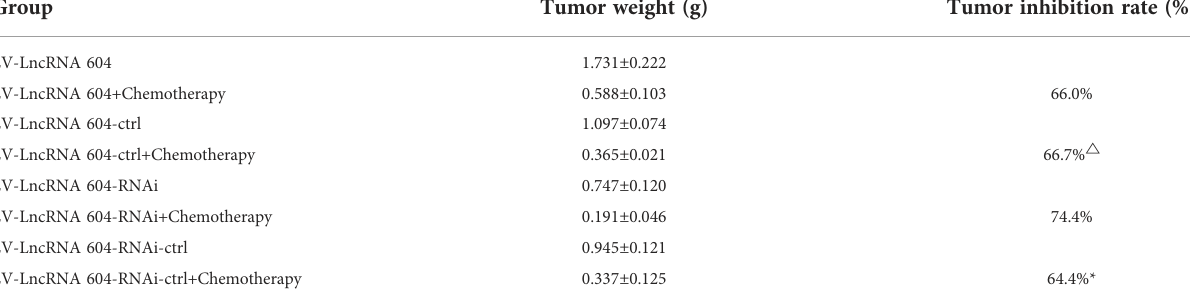
TABLE 4 Effects of chemotherapeutic drugs on subcutaneous tumor constructed by CRC cell lines of high-expressed or low-expressed lncRNA 604 and respective control cell ( X ± S, n = 3). Group Tumor weight